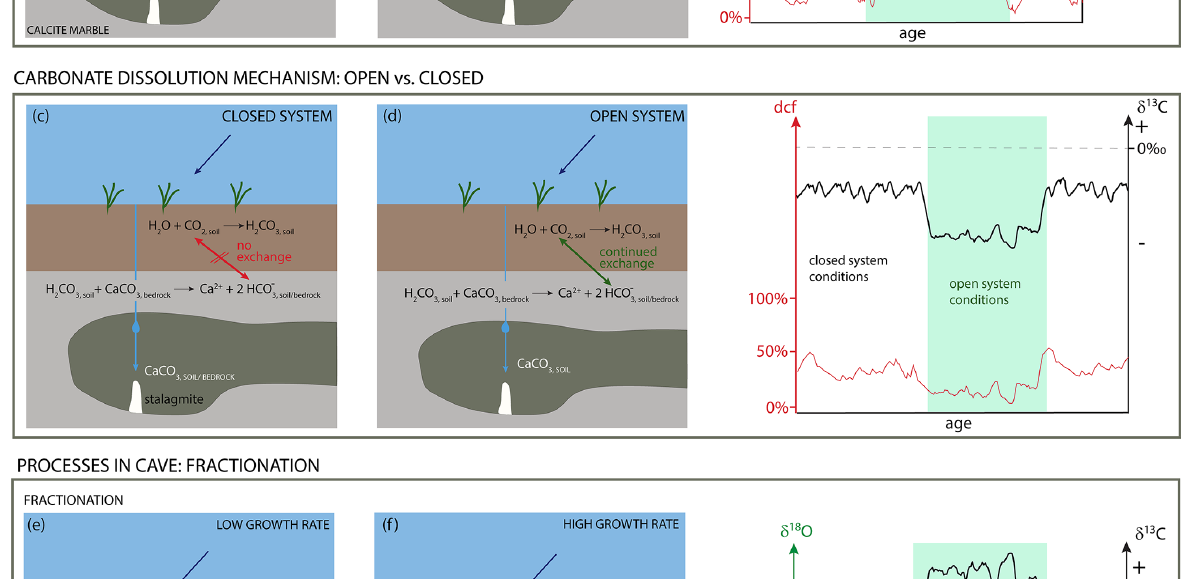
Figure 4. Overview of different processes that can influence F 14 C and δ 13 C in speleothems. For details see text.